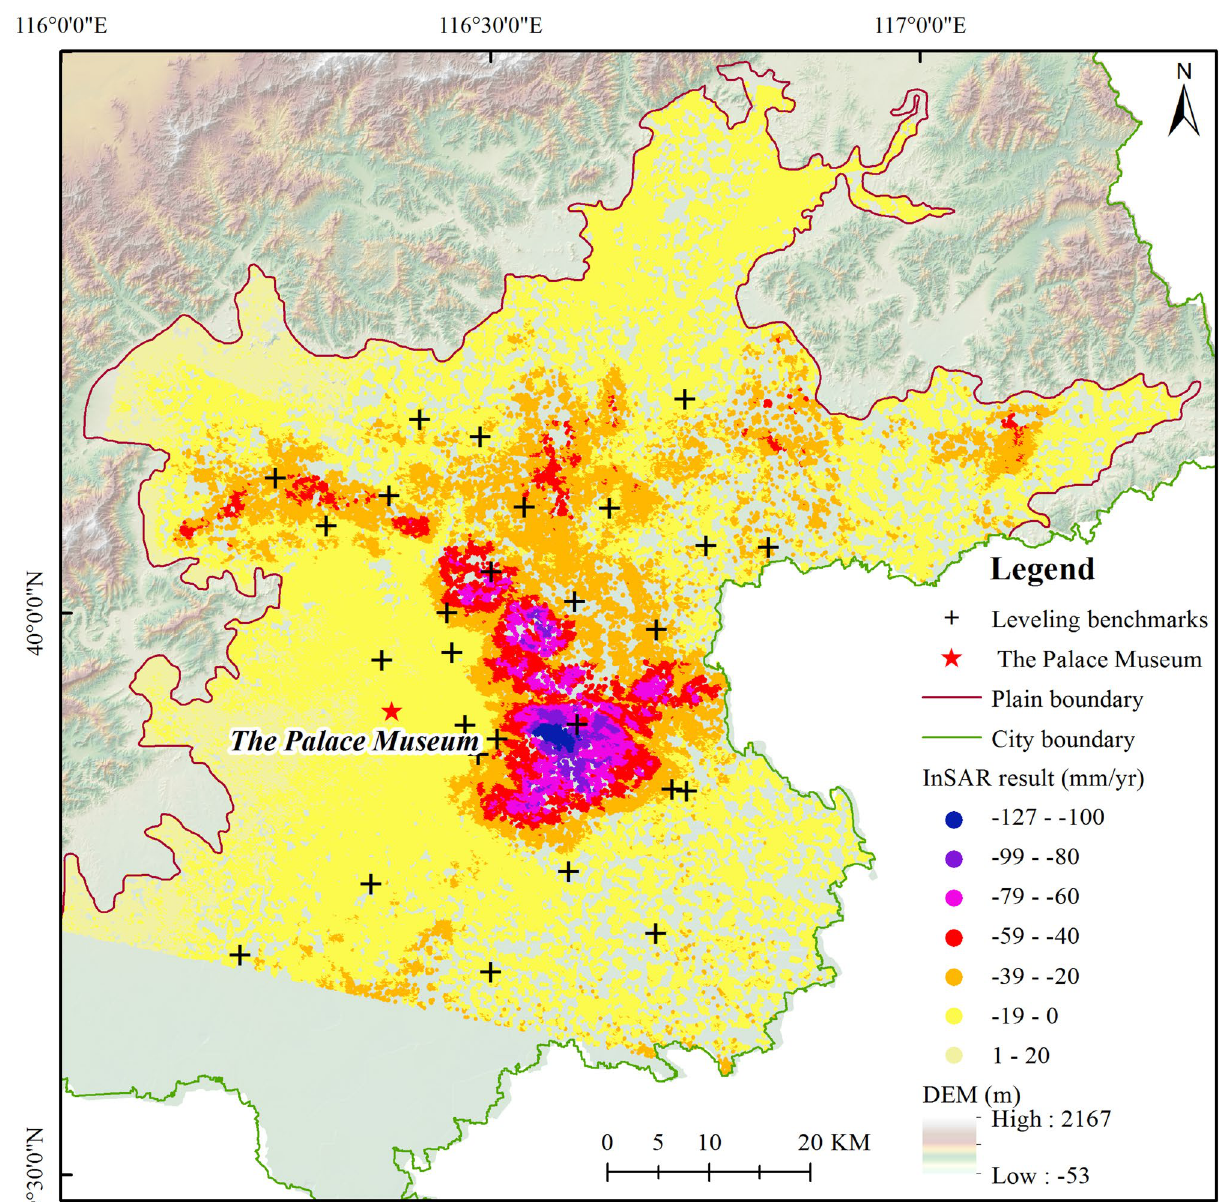
Figure 3. Land subsidence rate from June 2003 to November 2010 extracted by the IPTA method. The red star is the location of the Palace Museum, which is known as the center of Beijing. The article takes the Palace Museum as the center to carry out the WRM analysis. The black crosses are the locations of leveling benchmarks for the validation of the InSAR result. (Figure generated using ArcGIS v.10.6.0.8321, www. esri. were also obvious differences in the development of subsidence in different time periods in the same direction. The WRM is used to better explain the differences in land subsidence during each period and to better analyze the trend of land subsidence development and the diffusion and agglomeration characteristics of ground sub- sidence (Fig. 5b). The difference in land subsidence in each direction was based on the average of all PS points located within the corresponding subregion. There is an obvious difference in land subsidence in different time periods, which shows a certain directional characteristic. From 2004 to 2009, the development of the annual settlement in each direction was different. The amount of land subsidence significantly increased in some direc- tions, such as E, SEE and SE, which further highlights the difference in spatial subsidence development in each direction. Particularly, the subsidence has a trend of agglomeration in the E and SEE directions. The E and SEE subregions cover the Dongbalizhuang-Dajiaoting subsidence center, which was the center of industrial develop- ment the early days. The nature of subsidence also presents a staged development; it grew rapidly before 2008, stagnated or even decreased in 2008, and then progressed after 2008. The standard deviation of subsidence in each subregion can be described in Fig. 5c. The difference in PS points within each subregion varies greatly. The subsidence in the NW, NNW, E and SEE subregions has larger